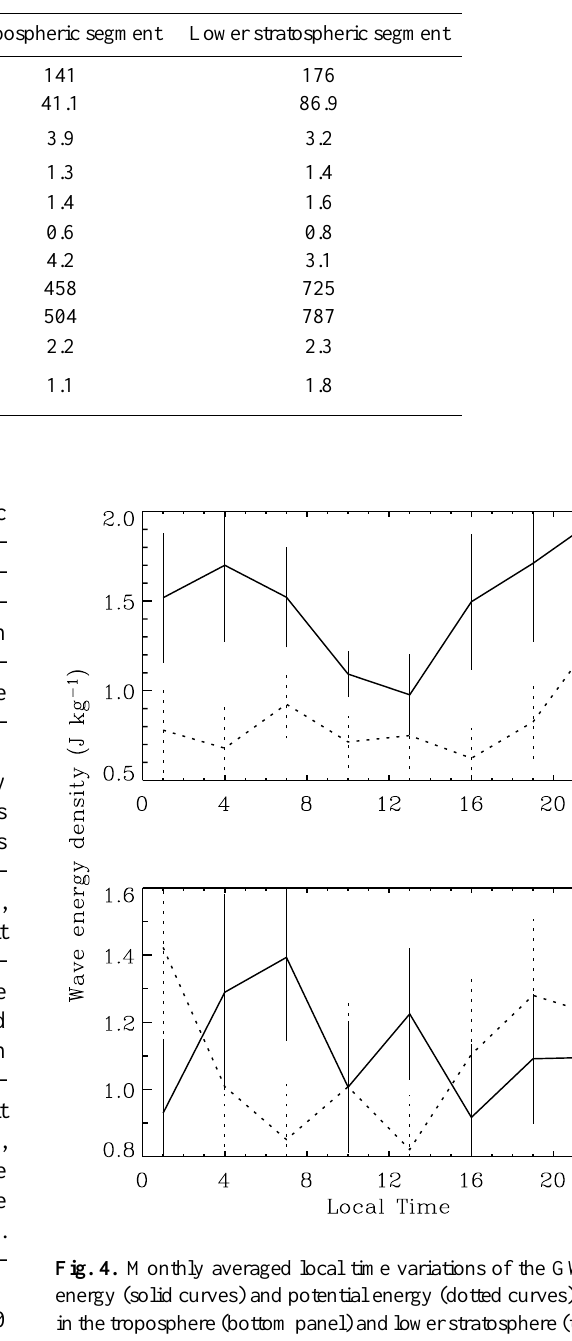
Table 1. Mean values of GW parameters in August 2006. λ z , λ x and λ y stand for the vertical, zonal and meridional wavelengths, respectively; the over bars denote an unweighted average.